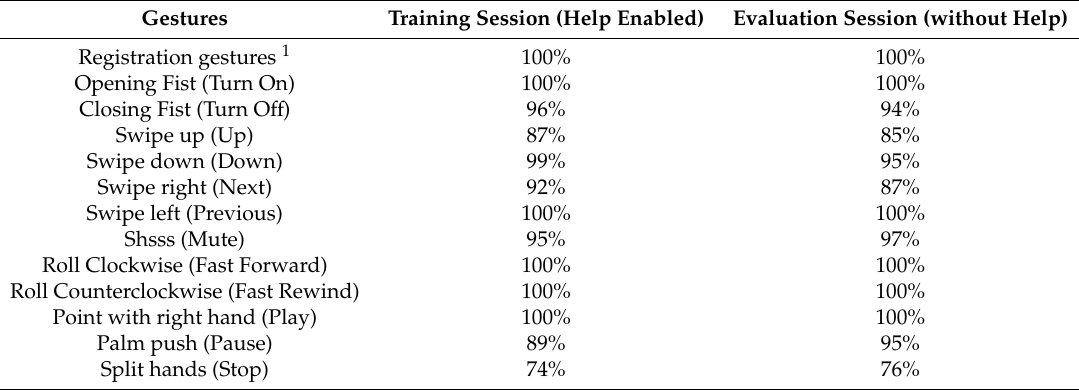
Table 4. Gesture success during the training and the evaluation session. Between the two sessions the higher score is